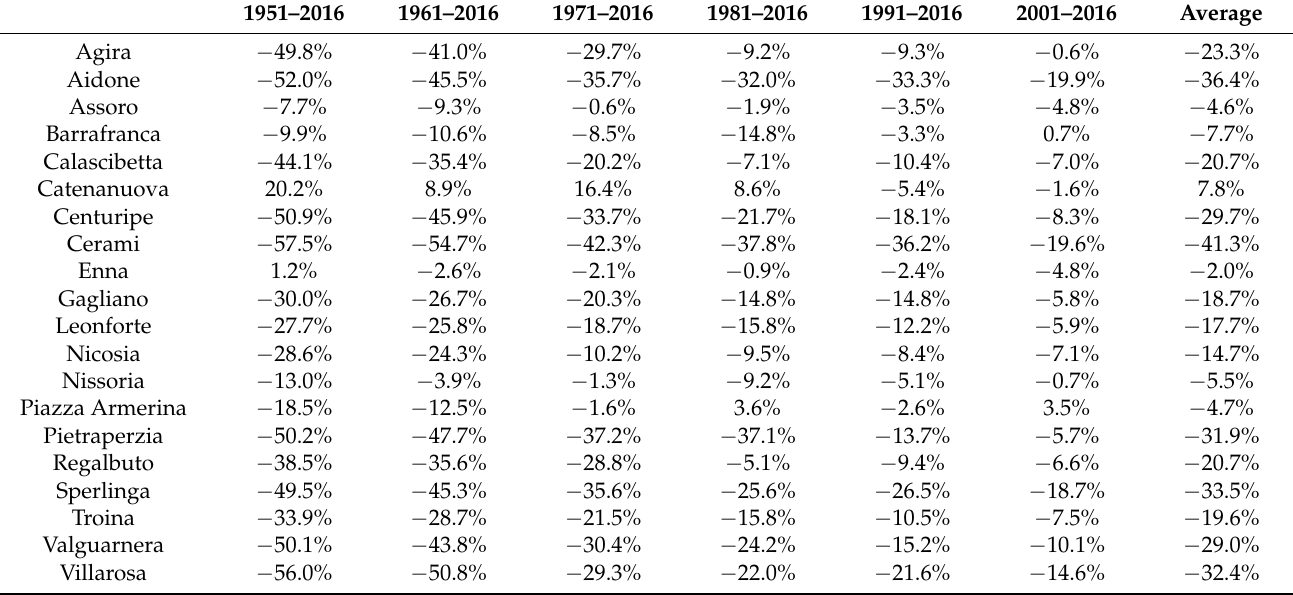
Table 3. Progressive population variation rates in the District of